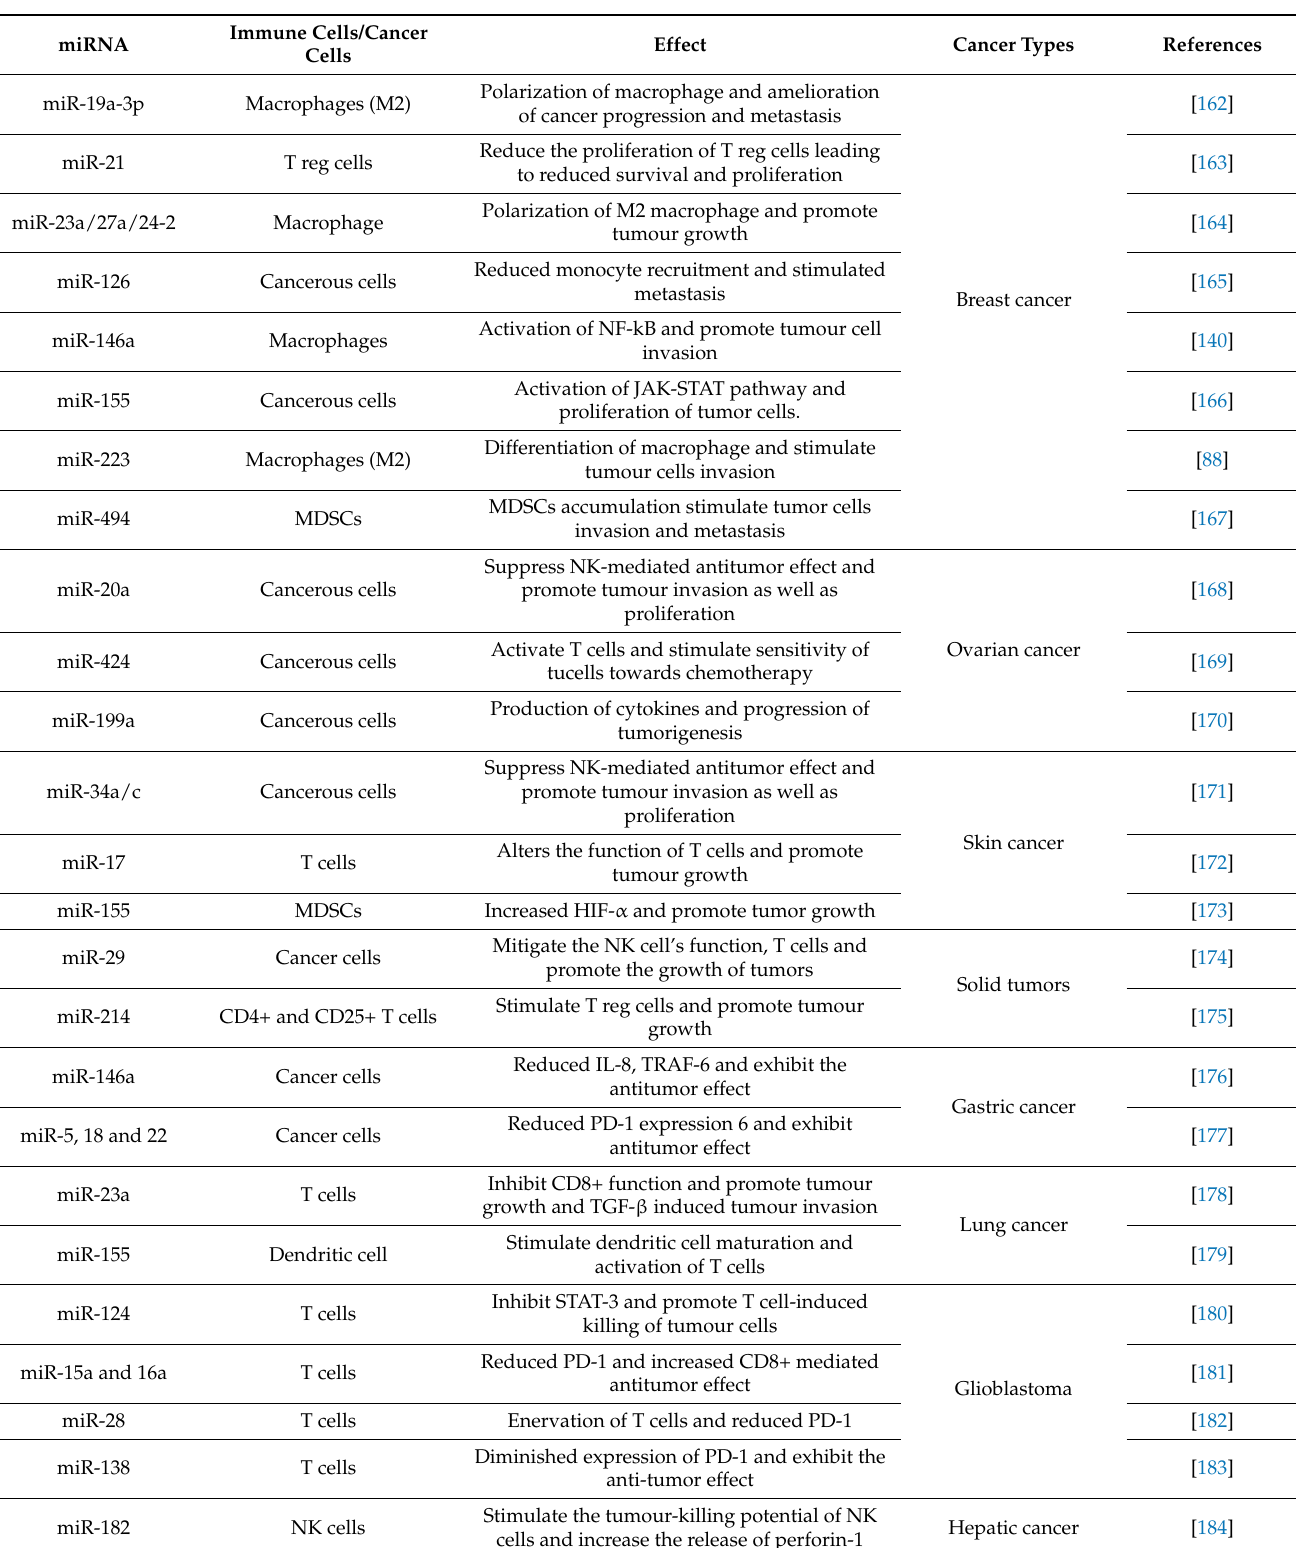
Table 4. Showing the modulatory effect of miRNAs via immune cells on